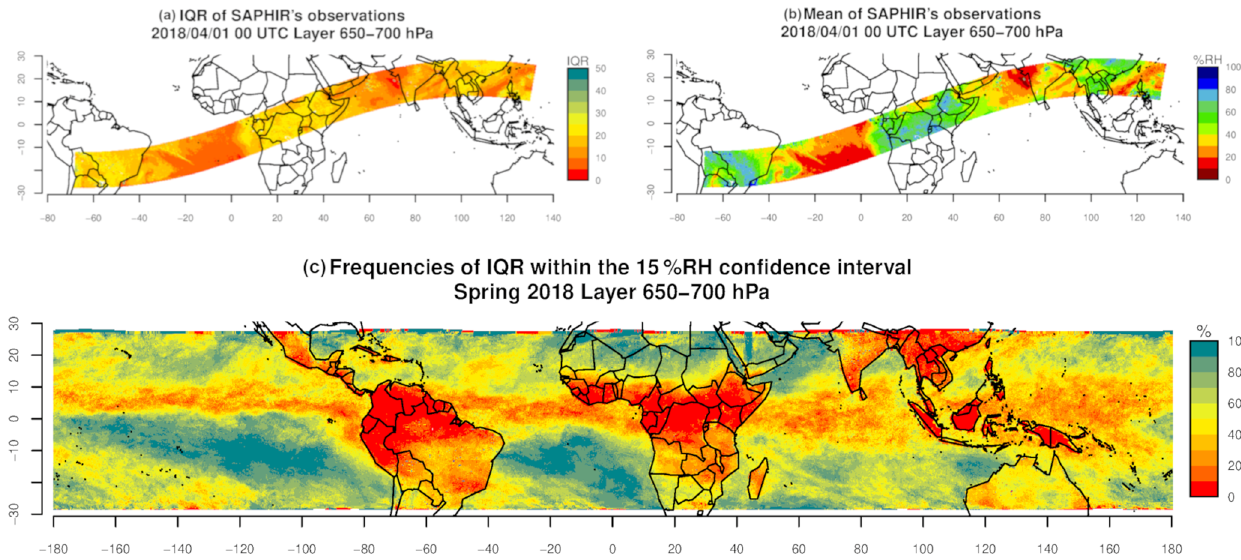
Figure 4. (a) Spatial distribution of the inter-quartile range (IQR) and (b) mean of reference (RH obs ) representing the observed spatial field of RH from SAPHIR on 1 April 2018 at 00:00UTC and in the 650–700hPa layer. (c) Frequency of IQR ≤ 15%RH over the 3-month period (April to June